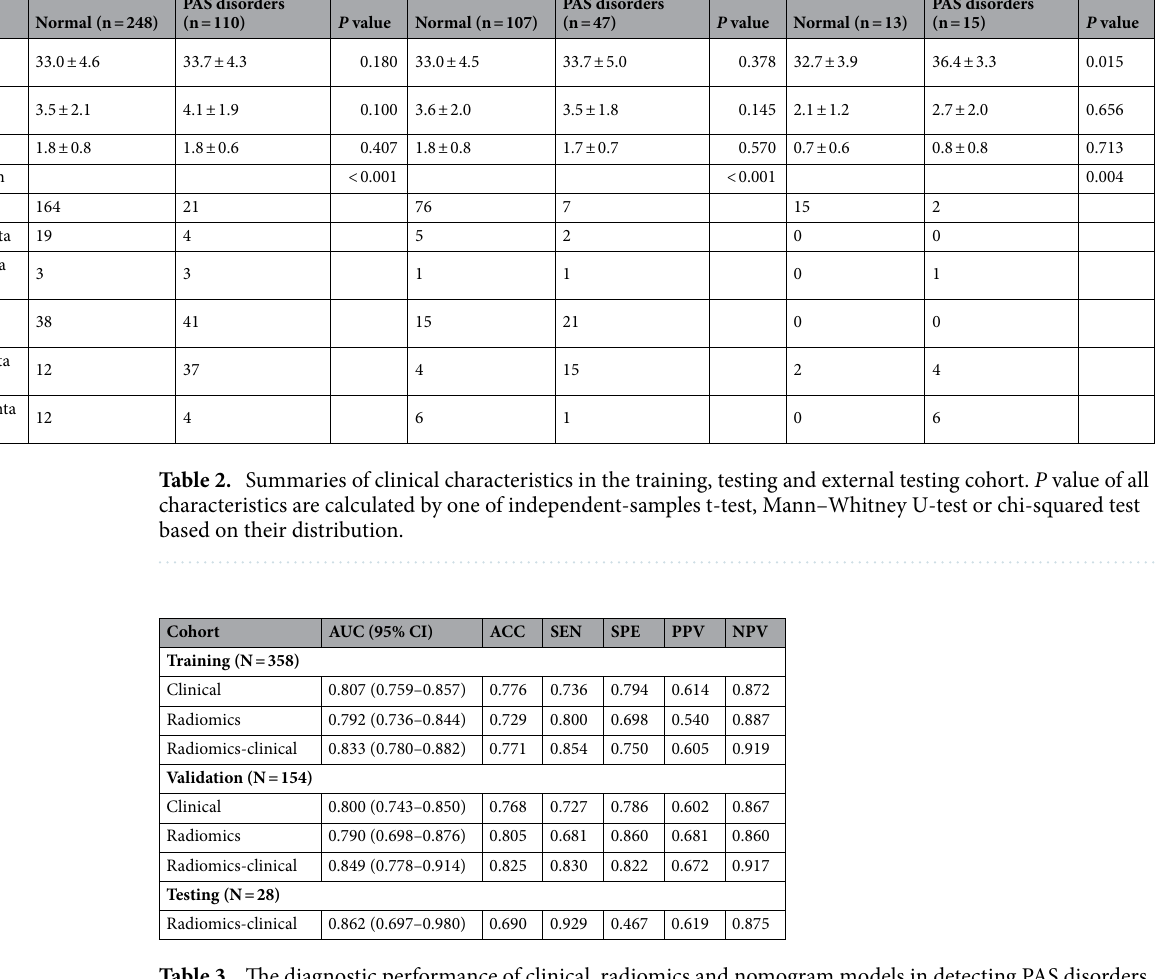
Table 3. The diagnostic performance of clinical, radiomics and nomogram models in detecting PAS disorders in training, validation and testing